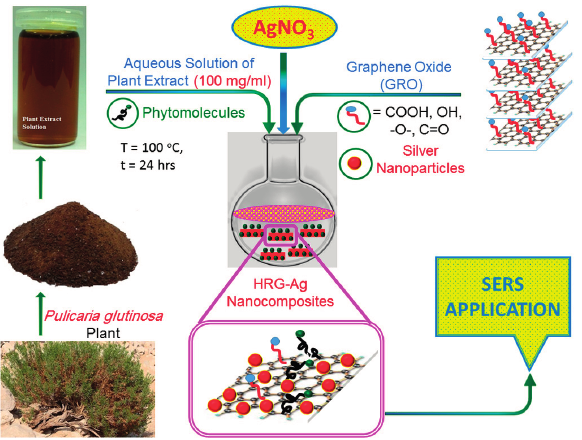
Scheme 1. Schematic illustration of the green synthesis of graphene/silver nanocomposites (PE-HRG-Ag) using aqueous extract of P. glutinosa